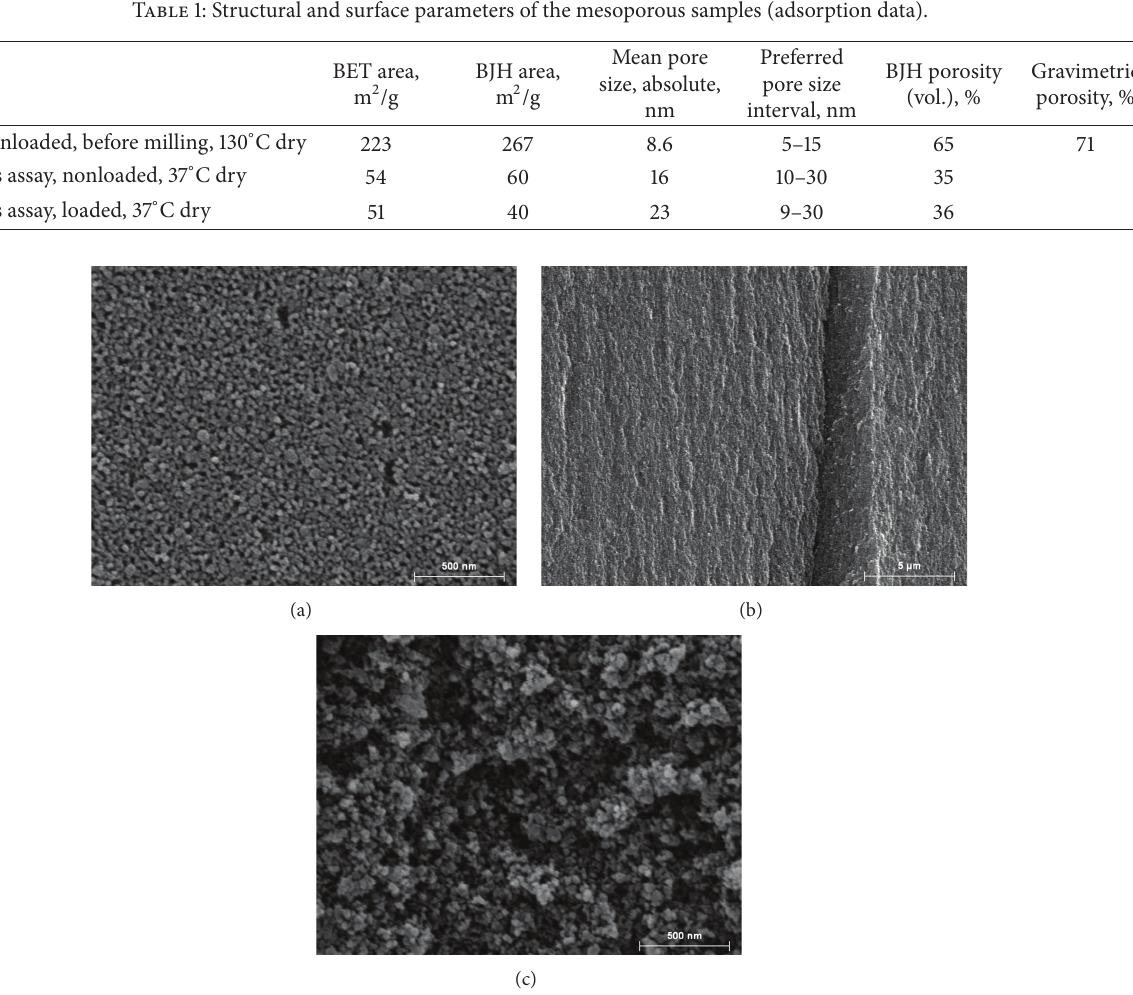
Figure 2: The scanning electron microscopy photos of the as-prepared porous silicon material: (a) in-plan view of the treated silicon wafer ( × 50.000), (b) transversal view of the porous material ( × 5.000), (c) particle surface after grinding ( ×